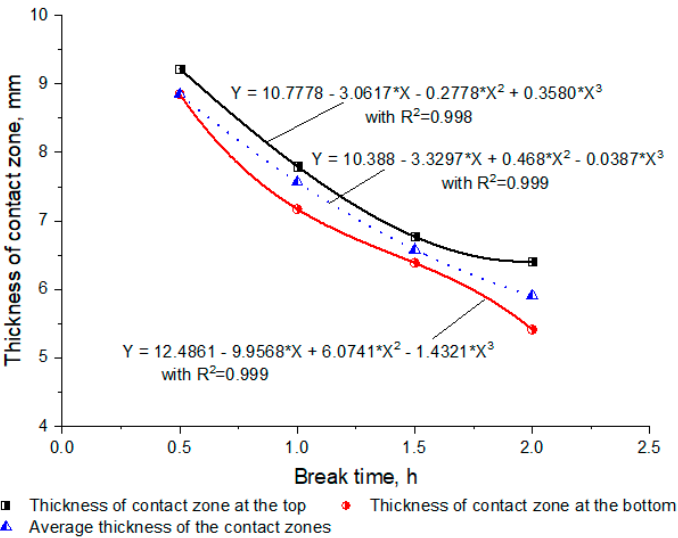
Figure 10. The dependence of the thickness of the contact zone on the break time.